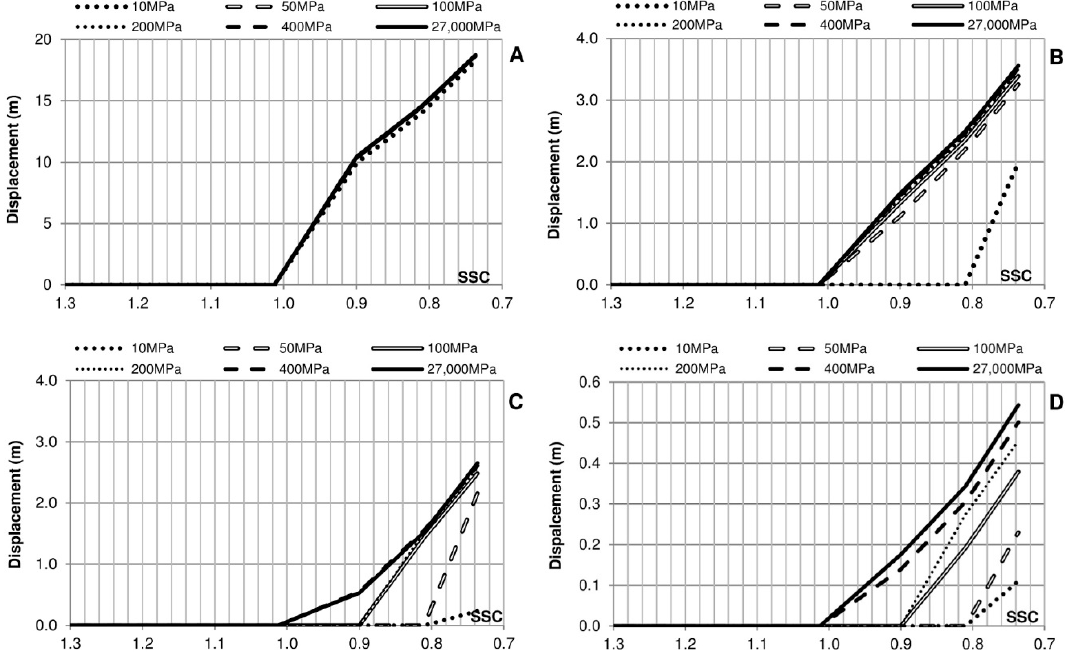
Figure 17. Crown wall displacement as a function of Sliding Safety Coefficient (SSC) and Young’s modulus of the soil, assuming elastic soil, for the 4 different theoretical signals: ( A ) Permanent; ( B ) Sinusoidal; ( C ) Impulsive 1; ( D ) Impulsive 2.